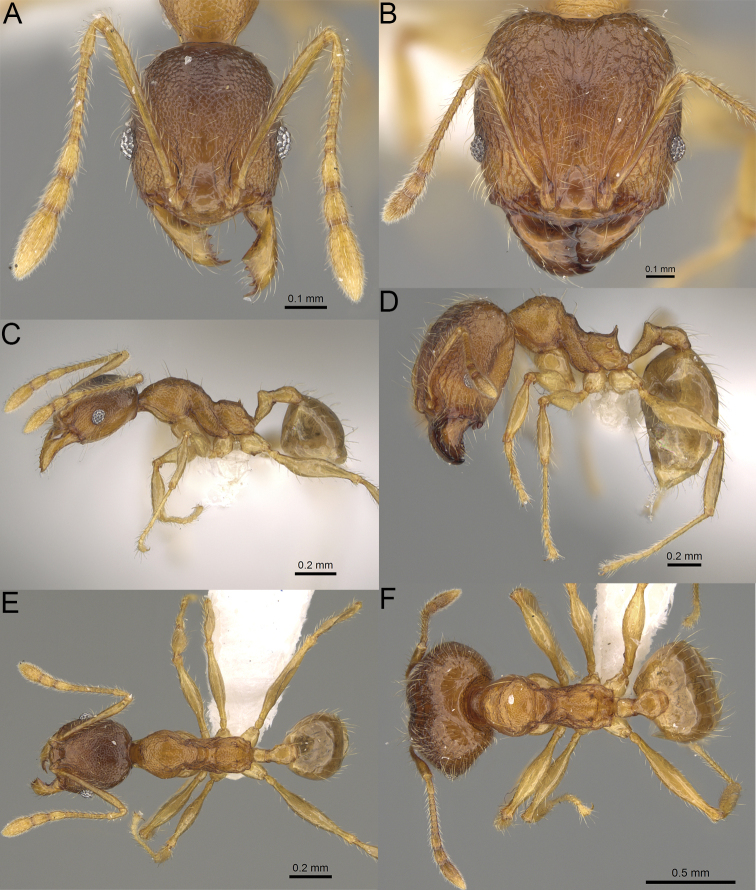
Pheidole
vadum sp. nov., full-face view (A), profile (C), and dorsal view (E) of paratype minor worker (CASENT0427785) and full-face view (B), profile (D), and dorsal view (F) of holotype major worker (CASENT0427789).